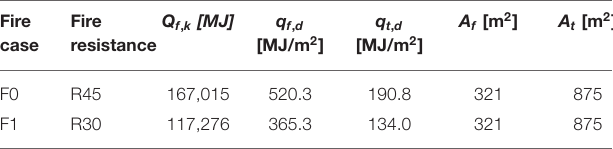
TABLE 1 | Design parameters of the fire load (EC